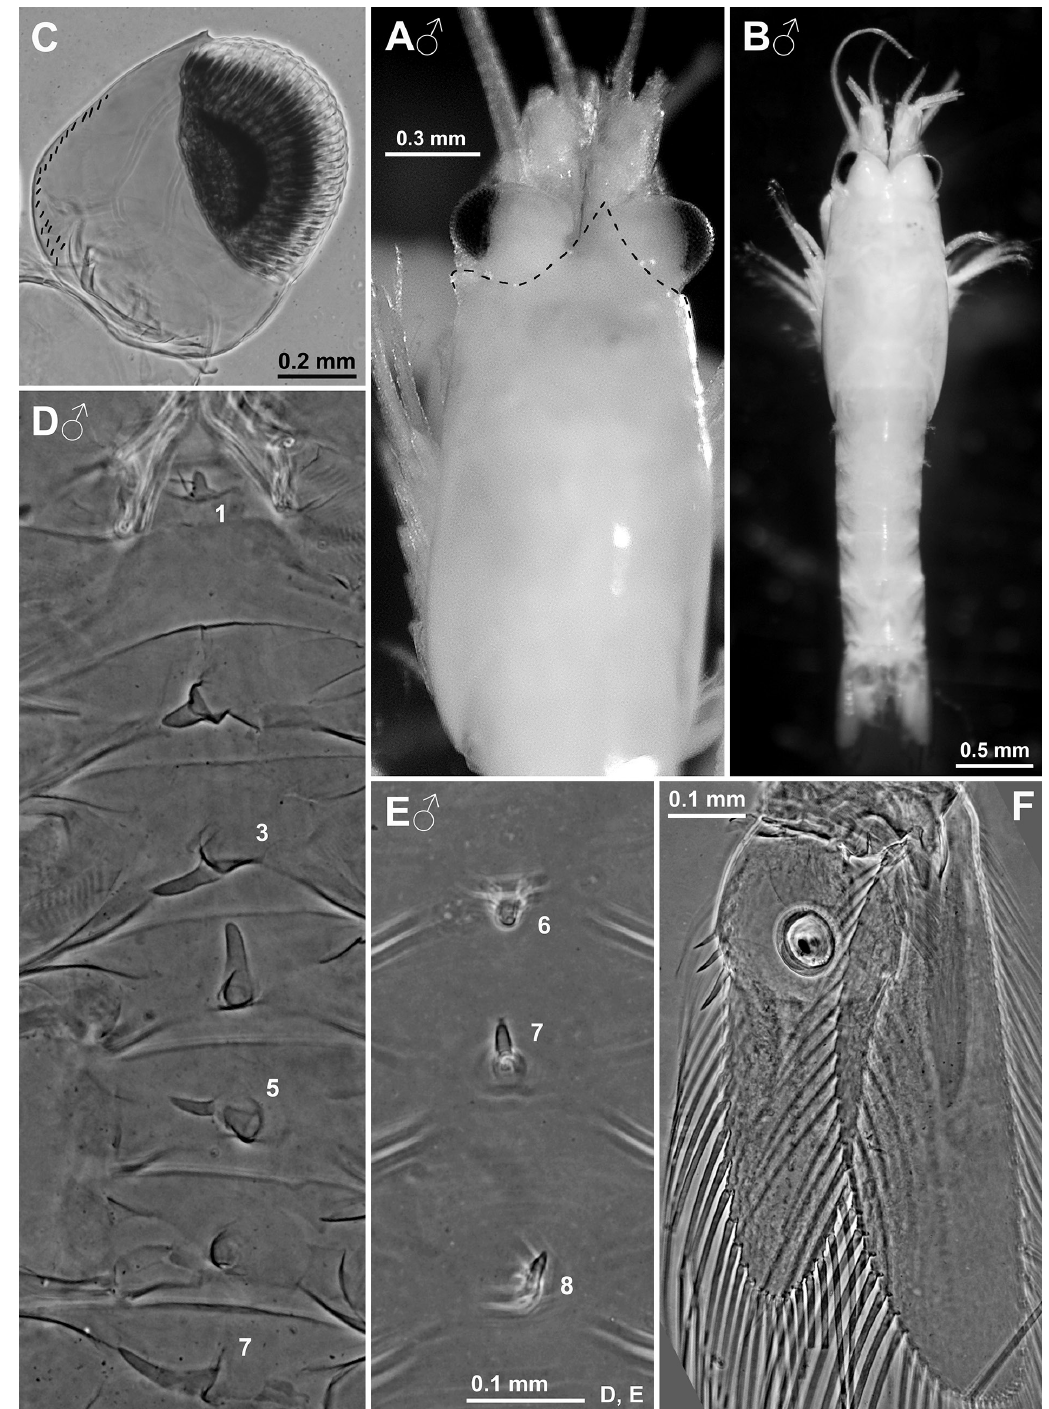
Fig. 4. Heteromysis hornimani sp. nov., holotype, ♂ with body length 4.0 mm (A: NHMW 26973) and paratypes, ♂♂ 3.4 mm (B: NHMW 26974), 4.7 mm (C–D: NHMW 26976 ), ♀ 5.2 mm (F: NHMW 26975 ), and non-type, ♂ 6.3 mm (E: NHMW 26980). A . Cephalothorax, slightly oblique dorsal view; dashed line illustrates the anterior contour of carapace. B . ♂ in toto, dorsal view. C . Left eye, ventral; contrast of scales on mesial margin of eyestalk is enhanced with black ink. D . Thoracic sternites 1–7 expanded on slide, ventral. E . Sternites 6–8 in non-type. F . Uropods, dorsal. A–F. Ethanol-fixed materials from aquaria in London (A–D, F) and Brest (E); on petri dishes (A–B) and slides